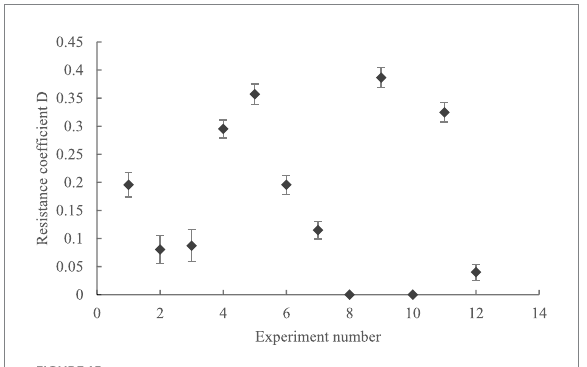
FIGURE 15 Variation of resistance coefficient with the number of leaf layers and initial